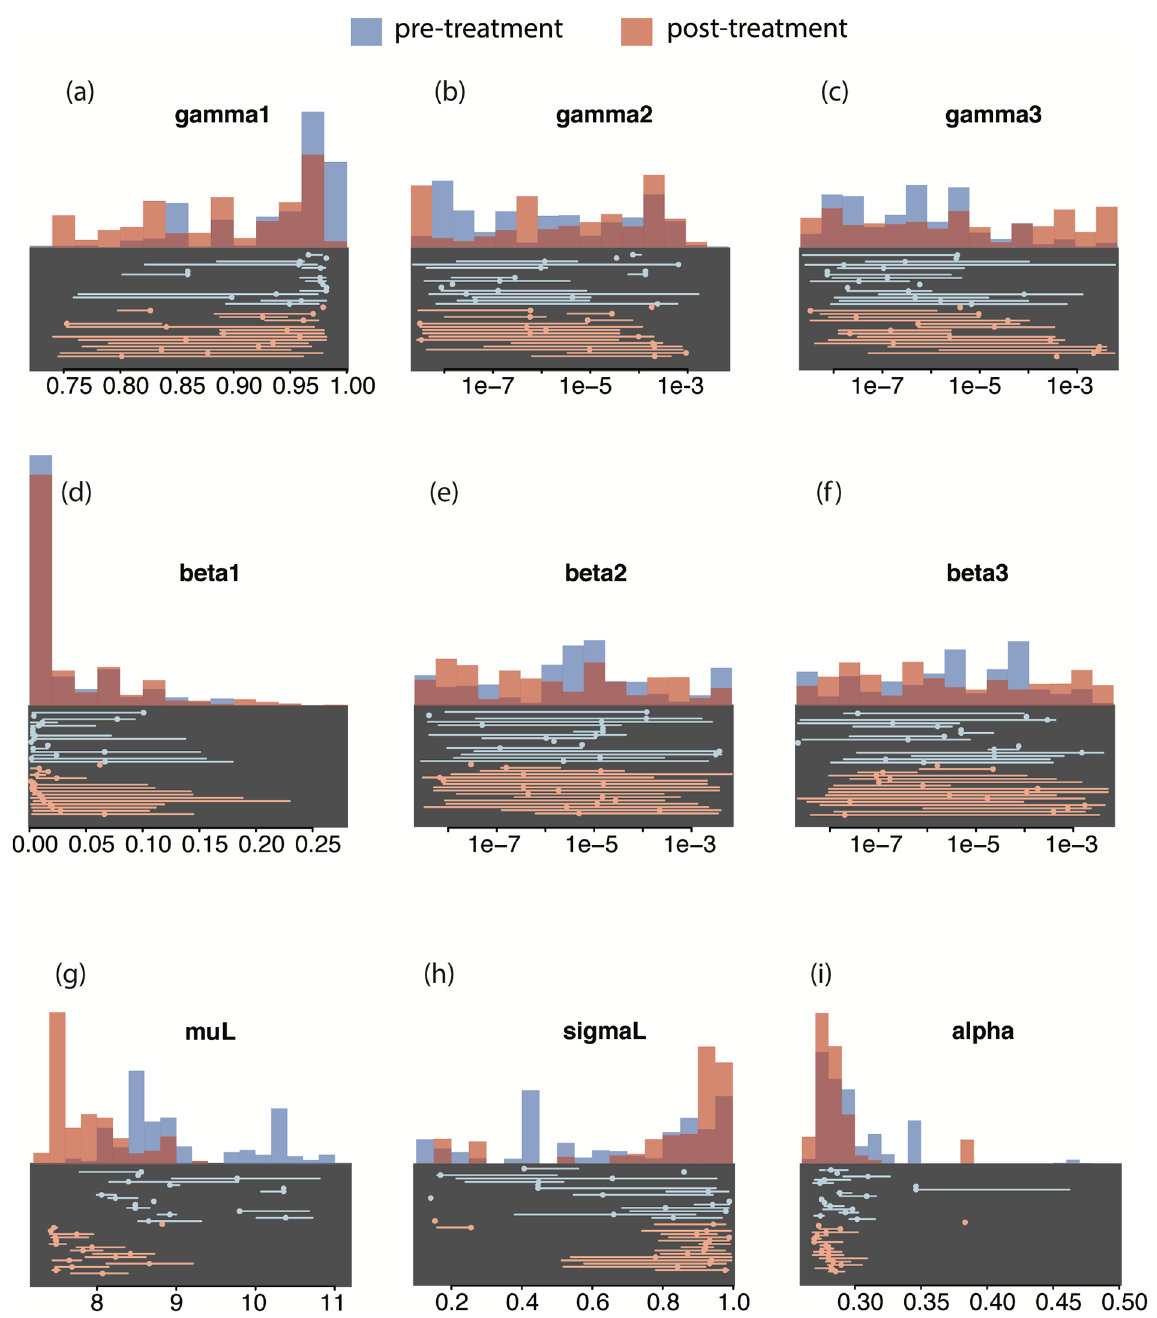
Fig 3. Marginal posterior distributions for parameter estimates. Panels give the sampled posterior distribution, conditional on the observations from all rabbits, for (a) baseline establishment, γ 1 , (b) effect of cumulative exposure on establishment, γ 2 , (c) effect of parasite intensity on establishment, γ 3 , (d) maximum daily clearance, β 1 , (e) effect of cumulative exposure on establishment, β 2 , (f) effect of parasite intensity on establishment, β 3 , (g) mean final length, μ L , (h) variance in final parasite length, and σ L (i) parasite growth rate, α . The posterior for pre-treatment animals is shown in blue, the posterior for post-treatment animals is shown in red. The x-axis in each panel spans the range of the uniform prior for each parameter. Below each panel is shown the posterior mean (circle) for each individual animal and the central 95% of the rabbit-specific posterior distribution. Estimates for animals sampled on days 15, 30, 45, 60 are plotted from top to bottom; pre-treatment animals are shown in blue, post-treatment animals are shown in